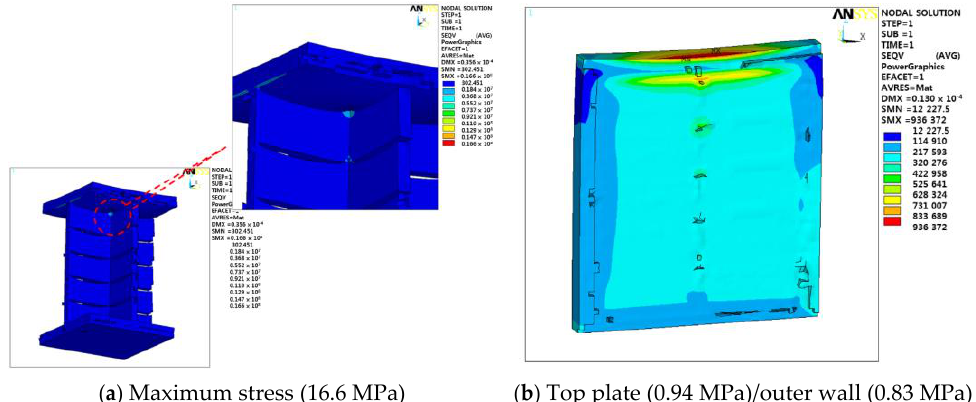
Figure 11. Computational finite element analysis results (stress).